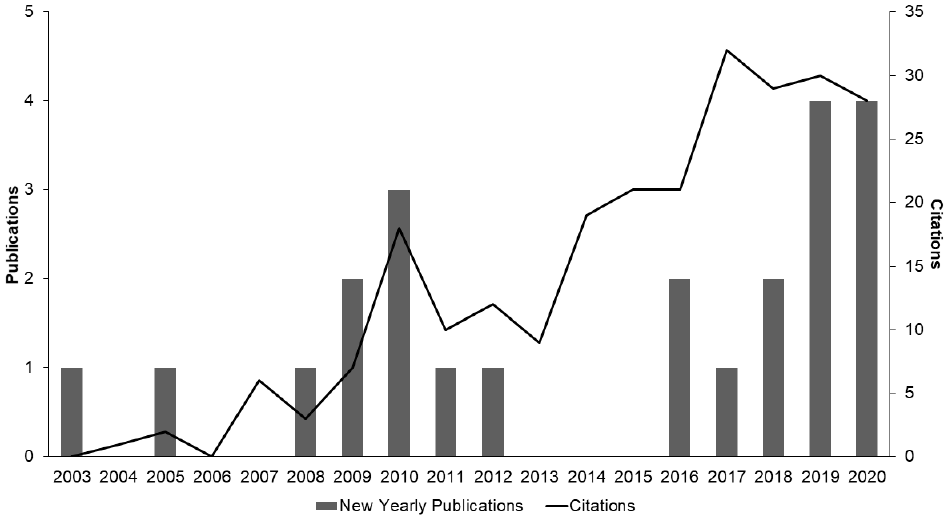
Figure 6. Yearly publications and the number of citations for articles matching the search TOPIC: ( Cannabis sativa OR hemp) AND TOPIC: (regeneration) AND TOPIC: (micropropagation OR In Vitro OR tissue culture) on the Web of Science database. Data obtained from Web of Science®on 17 Novem- ber 2020 using Microsoft Edge®. Data presented may not be a comprehensive representation of the available publications and are limited to publications indexed by Web of